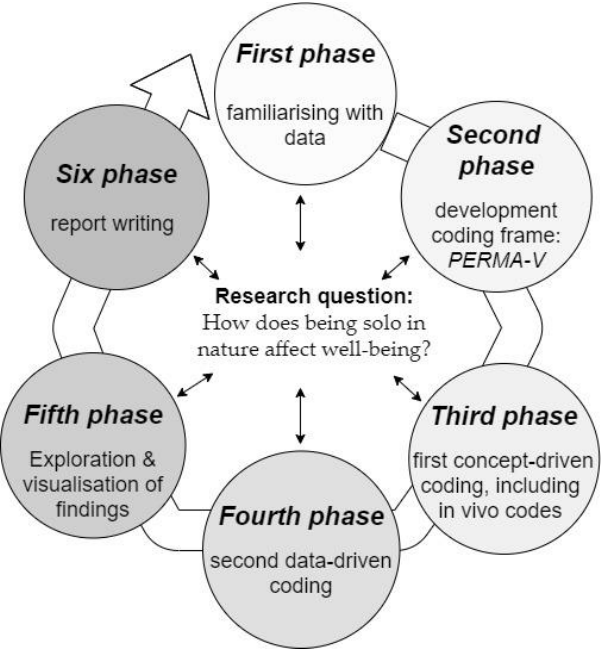
Figure 1. The six phases of the qualitative content data analysis, adopted from Rädiker and Kuckartz [41].